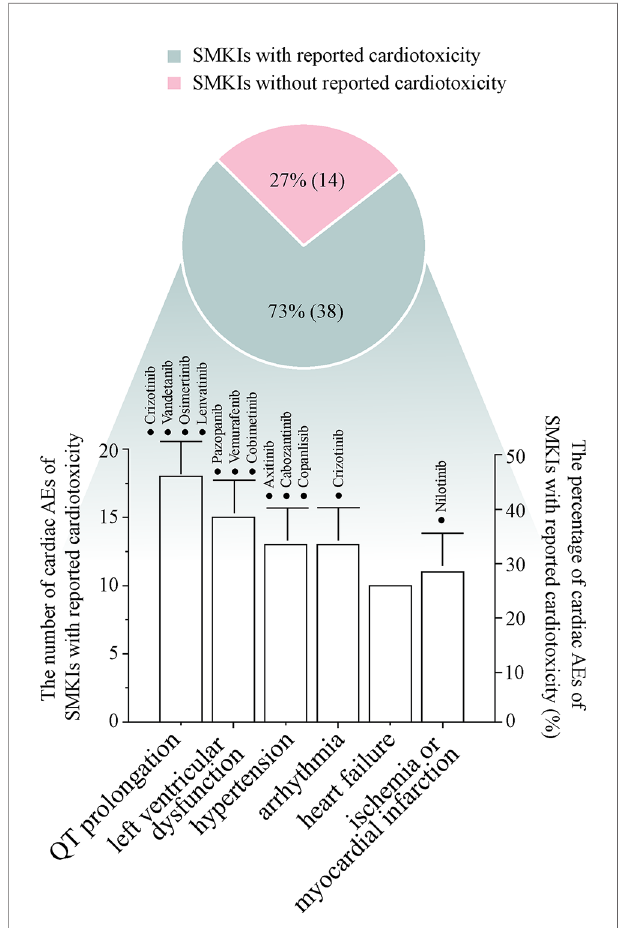
FIGURE 1 | The pie diagram shows the percentage of SMKIs with reported cardiotoxicity in 52 FDA-approved SMKIs, and the bar chart describes the numbers and percentages of representative cardiac adverse events in 38 SMKIs with cardiotoxicity. The drugs with ≥ 10% incidence of cardiac adverse events are highlighted in the bar